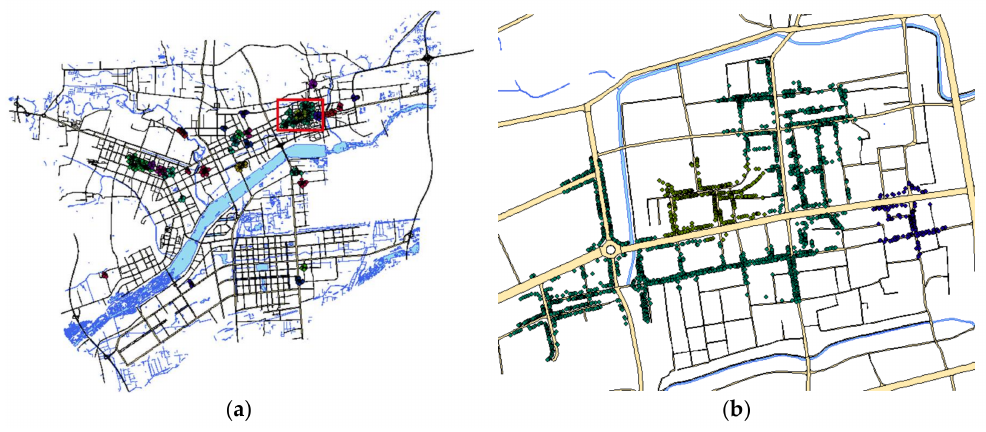
Figure 6. Spatial Data Clustering. ( a ) Clusters (radius = 110, density = 80); ( b ) Detailed view of area in red in the left